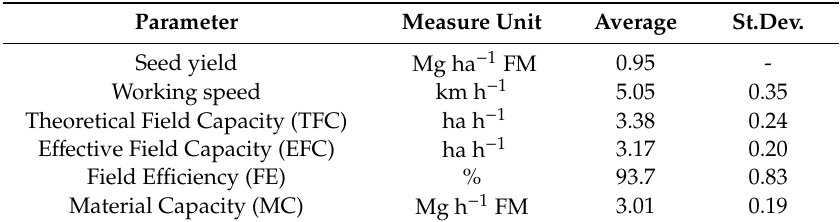
Table 4. Work performance analysis results.